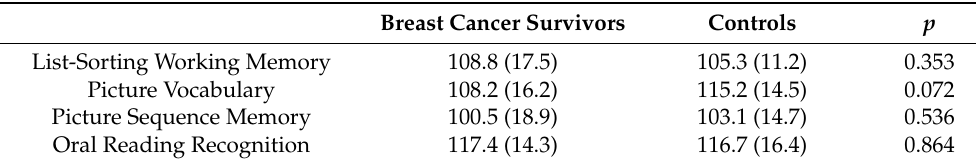
Table 2. Objective Cognitive Function 1 .